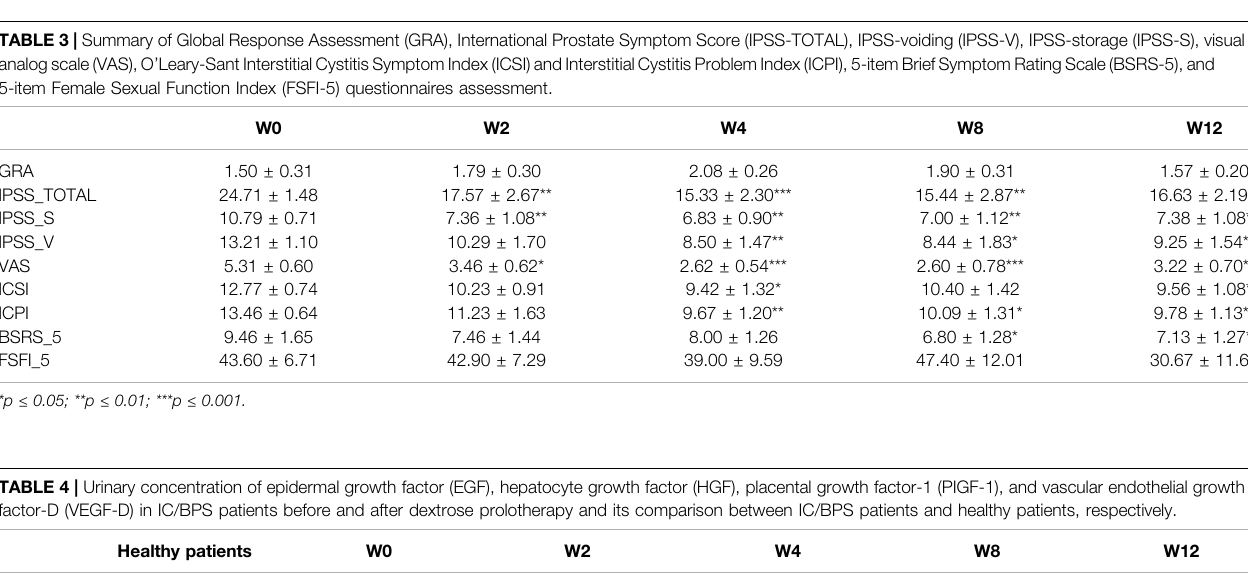
TABLE 4 | Urinary concentration of epidermal growth factor (EGF), hepatocyte growth factor (HGF), placental growth factor-1 (PIGF-1), and vascular endothelial growth factor-D (VEGF-D) in IC/BPS patients before and after dextrose prolotherapy and its comparison between IC/BPS patients and healthy patients, respectively.